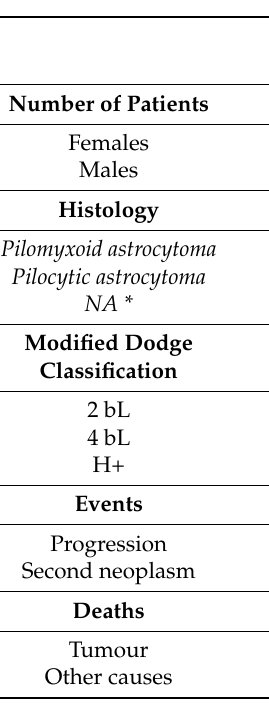
Table 1. Patients’ characteristics. * NA—not